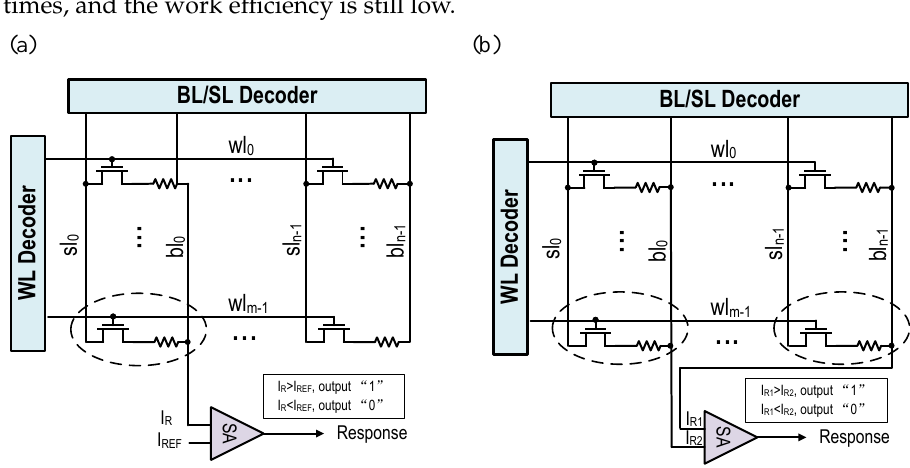
Figure 1. ( a ) Traditional RRAM-based weak PUF. ( b ) Traditional RRAM-based strong